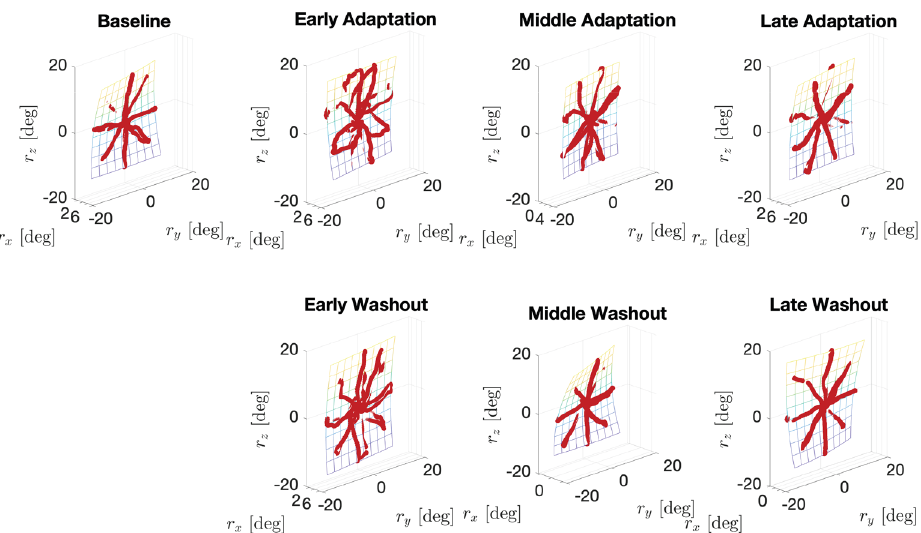
Figure 3. Donders’ surfaces for a representative participant, showing baseline , adaptation (divided into early trials 1 ÷ 10, middle trials 11 ÷ 25—and late trials 26 ÷ 40) and washout (divided into early, middle and late trials). Red dots represent recorded wrist